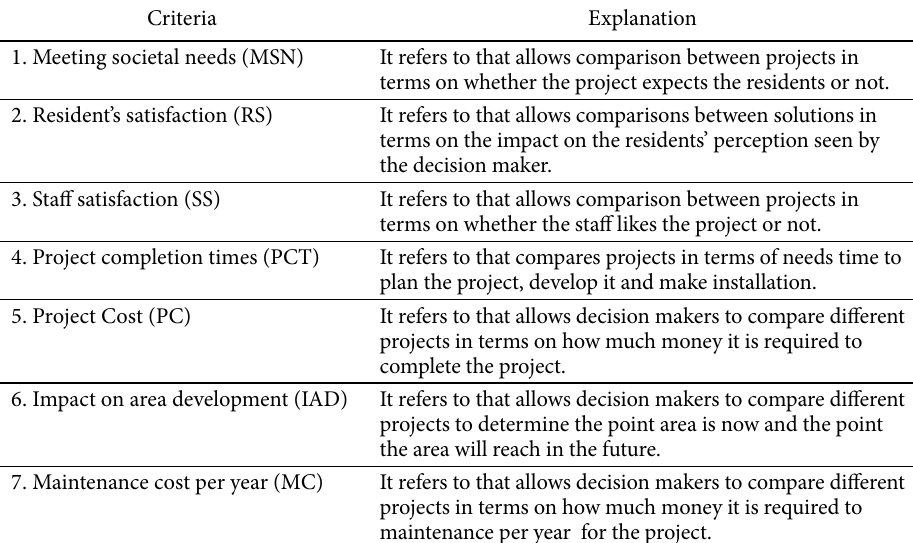
Table 5. Criteria used for the selection among municipal projects